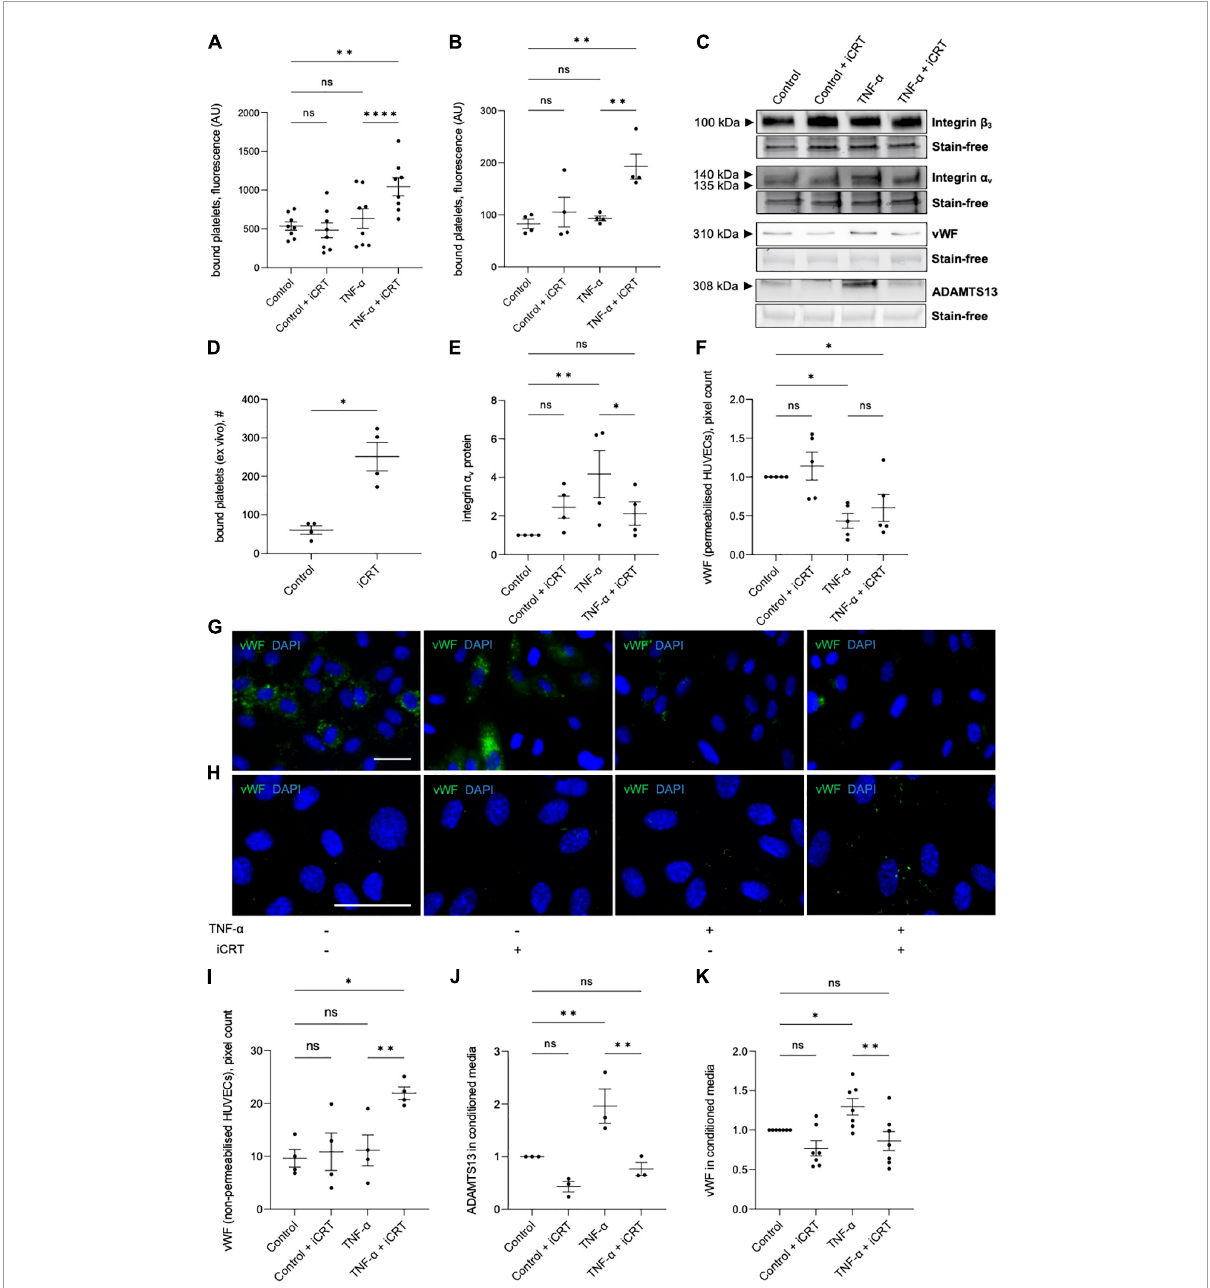
FIGURE5 Inhibition of Wnt/ β -catenin signaling enhanced platelet binding to TNF- α -stimulated endothelial cells. Cells were treated with either 0.05% DMSO vehicle control or 25 µ M inhibitor of β -catenin-responsive transcription (iCRT) in the presence or absence of 10 ng/mL recombinant human TNF- α stimulus for 18 h. BCECF-AM-labeled, thrombin-activated platelets were co-cultured with human umbilical vein endothelial cells (HUVECs) (A) and HCAECs (B) for 10 min, bound platelets lysed, and the fluorescent signal quantified. Data are expressed as optical density ( n = 8 and 4, respectively). (C) Representative Western blots for integrins α v and β 3 in whole cell lysates, and vWF and ADAMTS13 in conditioned media, and stain-free controls in HUVECs. (D) Segments of human saphenous vein were co-cultured with BCECF-AM-labeled, thrombin-activated platelets for 10 min, and the number of bound platelets quantified ( n = 4). (E) In HUVECs, integrin α v from whole cell lysates was quantified by Western blotting, normalized to stain-free controls and expressed as a fold change from control ( n = 4). Quantification and representative images of immunofluorescence (green) for vWF in permeabilised (F,G) and non-permeabilised (H,I) HUVECs, to detect intracellular and membrane-tethered vWF, respectively ( n = 5 and 4, respectively). Nuclei were stained with DAPI (blue). Scale bars represent 10 µ m and apply to all panels. From cultured HUVECs, ADAMTS13 (J) , and soluble vWF (K) in conditioned culture medium were quantified by Western blotting, normalized to stain-free controls and expressed as a fold change from control ( n = 7 and 3, respectively). ∗ Indicates p < 0.05, ∗∗ p < 0.01, ∗∗∗ p < 0.001, and ∗∗∗∗ p < 0.0001. NS denotes not